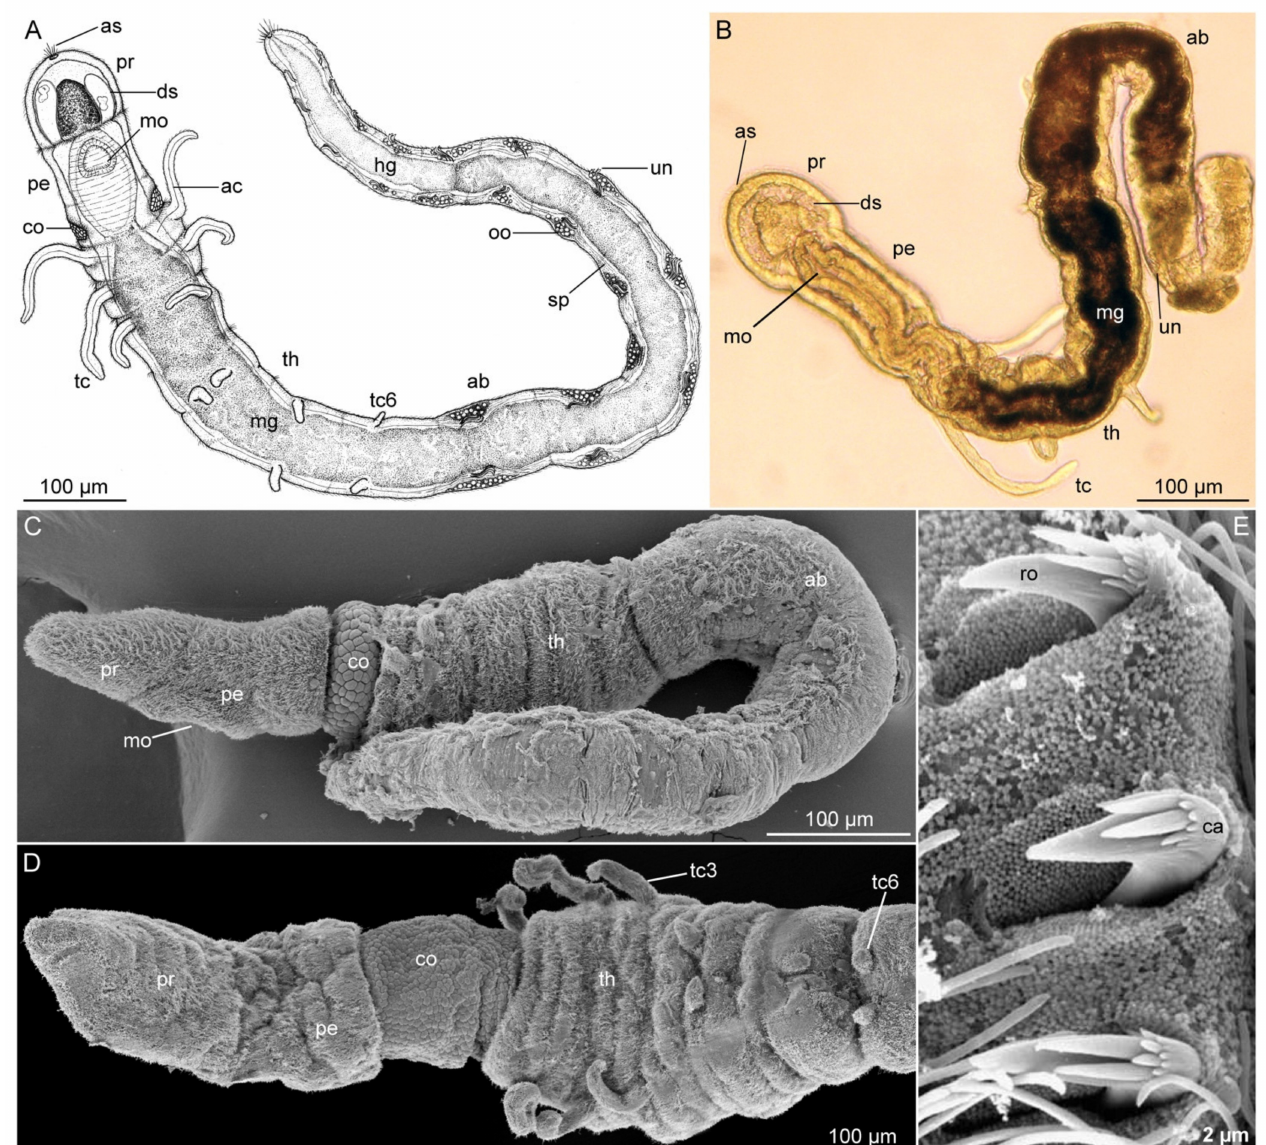
Figure 14. Morphology of Psammodrilidae. ( A ) Schematic illustration of Psammodrilus moebjergi . ( B ) Light micrograph of P. moebjergi , hind end lost. ( C – E ) Scanning electron micrographs. ( C ) Psammodrilus didomenico . ( D ) Anterior end of P. balanoglossoides from Denmark. ( E ) Uncini of P. moebjergi. ( A , B , E ) modified from [248]; ( C ), modified from [21]. Abbreviations: ab, abdomen; ac, acicula; as, anterior sensory cilia; ca, capitium; co, collar; ds, prostomial diaphragm sac; hg, hindgut; mg, midgut; mo, mouth opening; oo, oocyte; pe, peristomium; pr, prostomium; ro, rostrum; sp, sperm; tc, thoracic cirrus; tc3, tc6, third and sixth thoracic cirri; th, thorax; un,